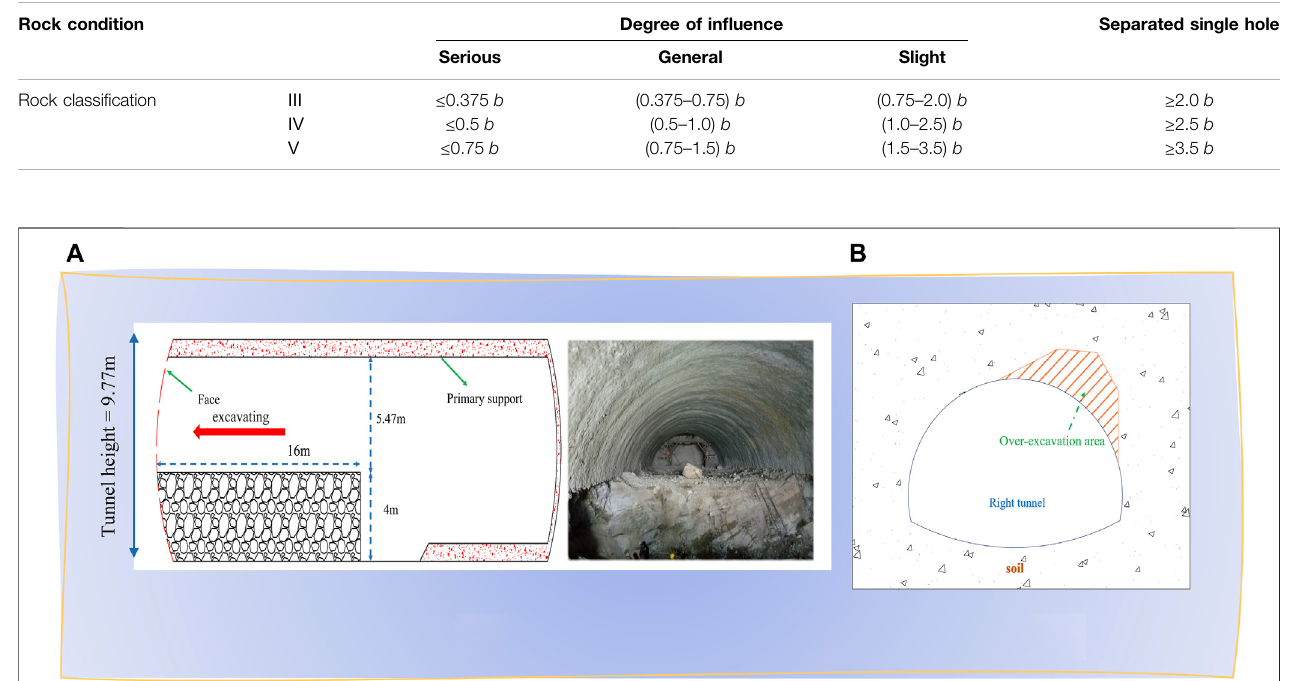
FIGURE 5 | Construction scheme at the collapse area and over-excavation event. (A) Schematic diagram of the bench-cut method, and the pictures of construction site inside the tunnel. (B) Schematic diagram of over-excavation area inside the tunnel.